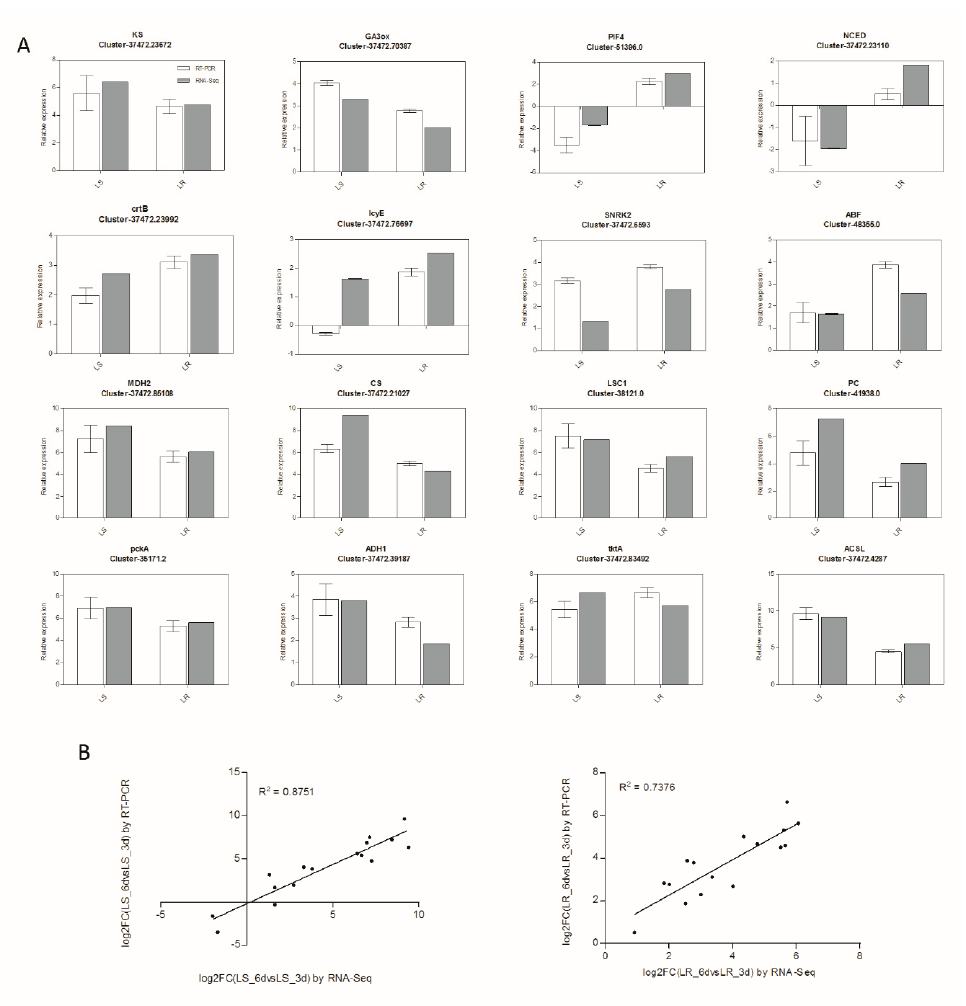
Figure 6. The validation of RNA-seq results using qRT-PCR. ( A ) The relative expression levels of 16 DEGs determine by qRT-PCR (white column) and RNA-Seq (grey column). RNA-Seq results (fold change) and qRT-PCR results (2 − ∆∆ Ct ) were transformed to log 2 forms. Bars are mean ± standard error (n = 3). ( B ) Linear regression analysis of the RNA-Seq and qRT-PCR results. The R 2 values represent the correlation between RNA-Seq and qRT-PCR